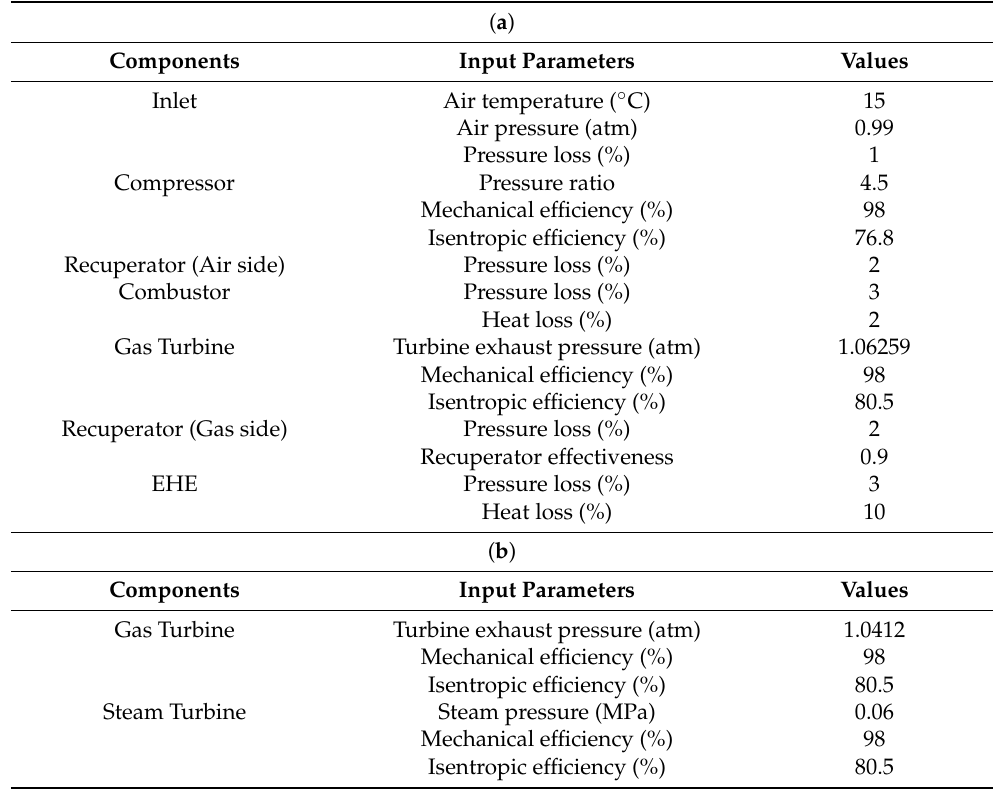
Table 2. ( a ). Main parameters of recuperative cycle micro gas turbine system. ( b ). Main parameters of gas-steam combined cycle